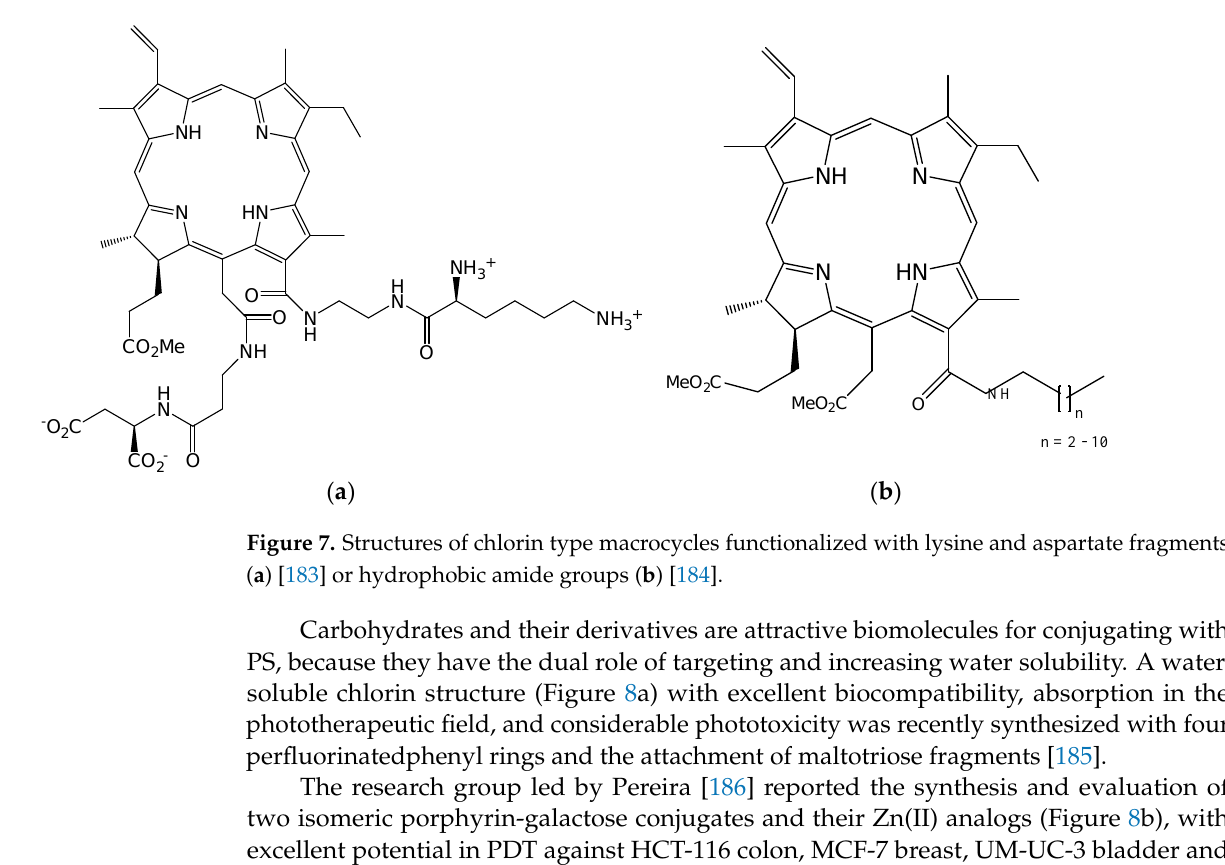
Figure 6. Structures of porphyrin type macrocycles functionalized with fragments of diethylamin- opentyl alchol (a) [154], ethylenediaminetetraacetic acid (b) [156], isoquinoline (c) [182], glucopy- ranoside (d) [157].